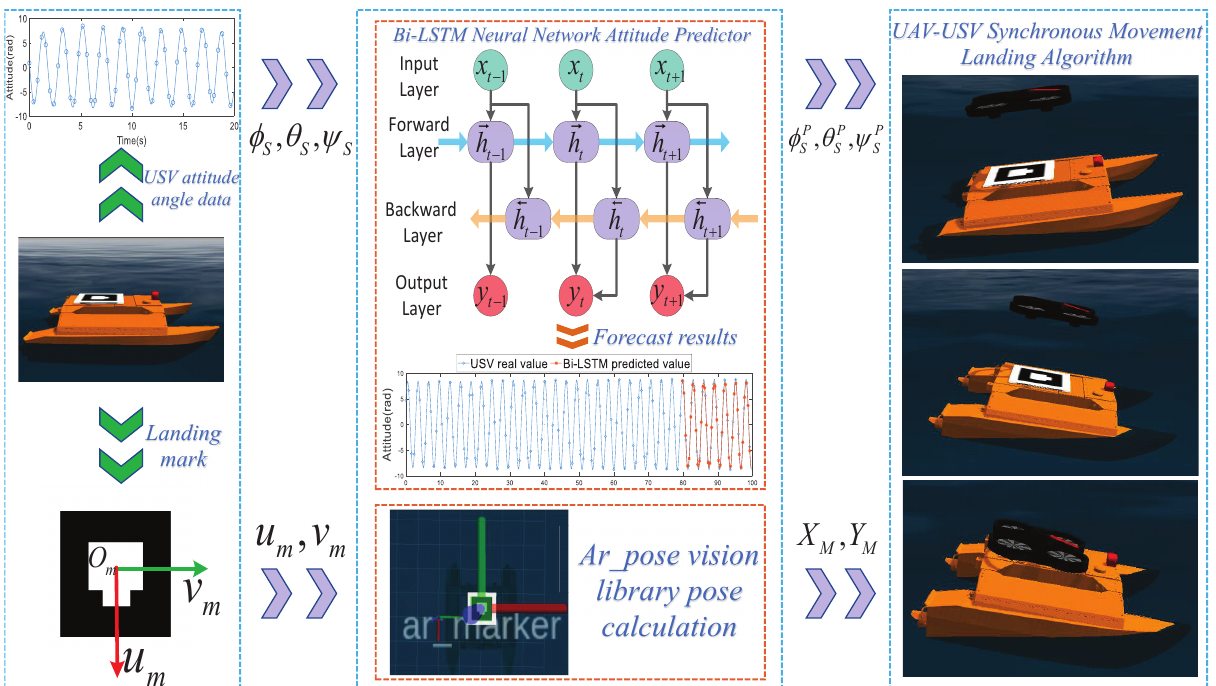
Figure 2. The overall framework of the method for precise UAV landing on a USV based on syn- chronized motion. Computer vision − based positioning to ensure that the UAV is always located directly above the landing mark center during the UAV landing process; a Bi-LSTM neural network is used to predict the USV attitude angle to ensure that UAVs respond to USV attitude changes in real − time; the UAV is controlled based on the PID algorithm, which makes the UAV and USV keep in synchronous movement for an accurate